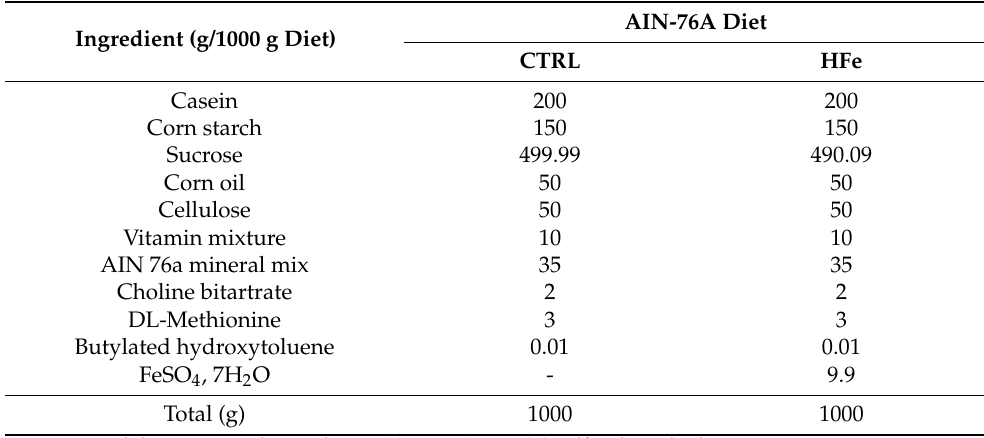
Table 1. Composition of different iron-concentrated